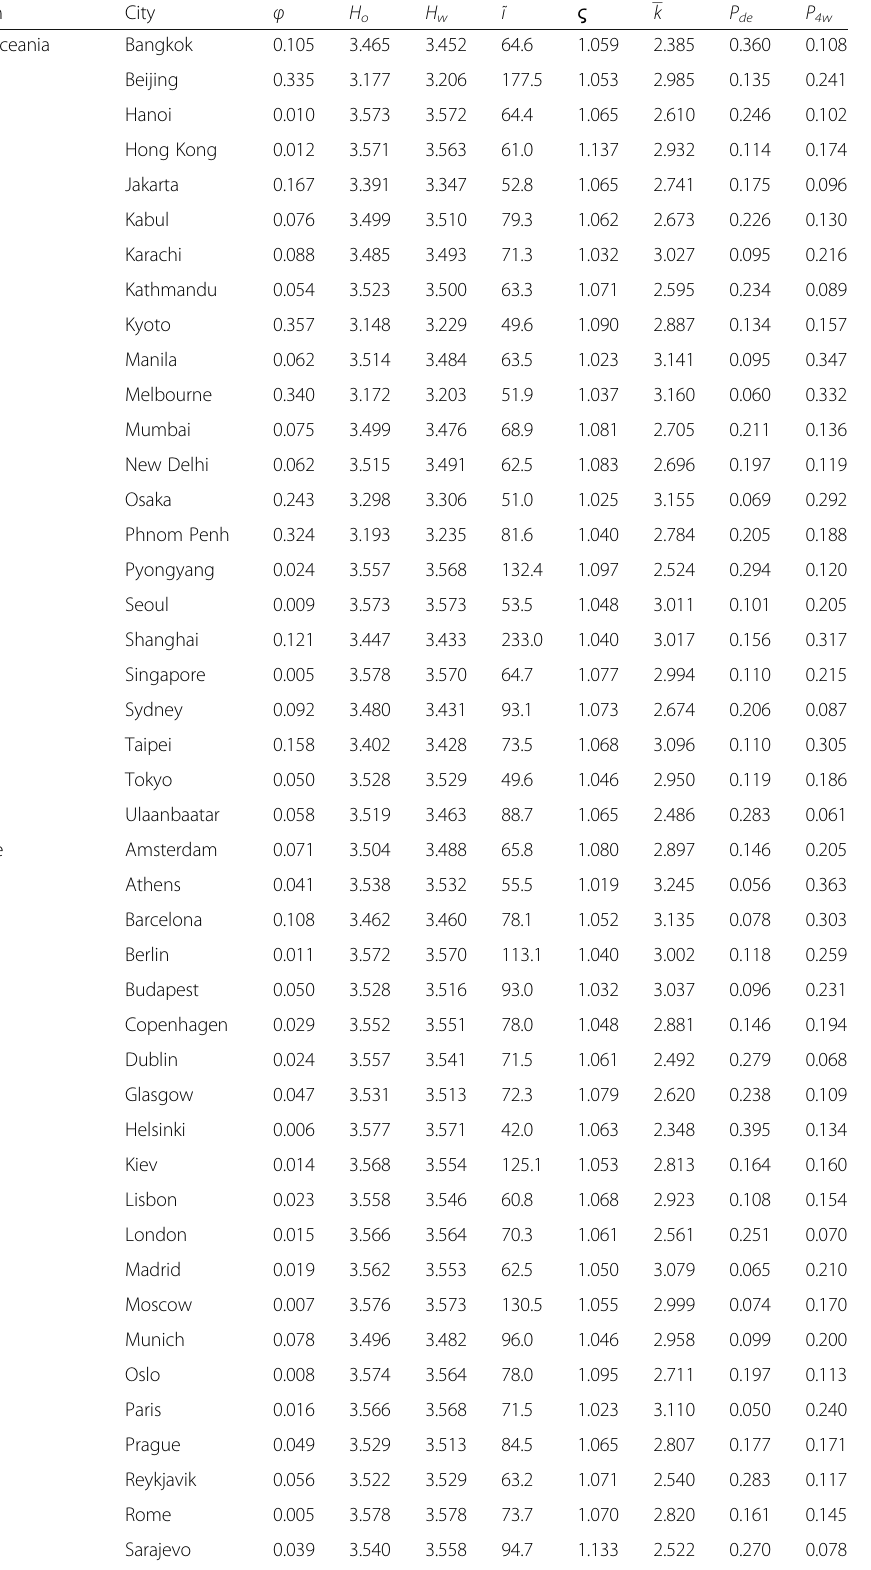
Table 1 Resulting indicators for the 100 study sites Region City φ